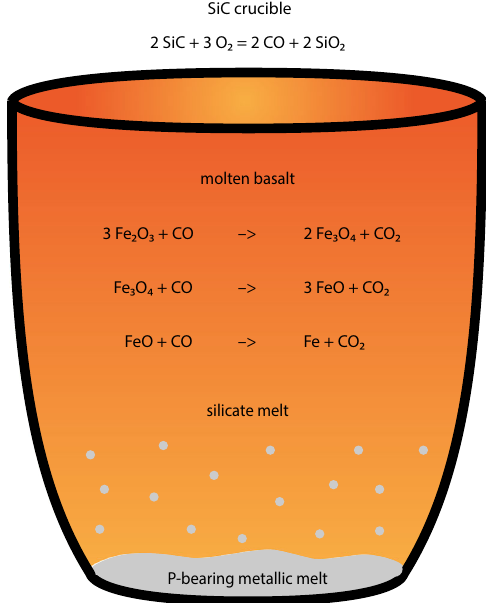
Fig. 7 Metallic melt segregation. Schematic illustration of the spontaneous segregation of metallic melt from silicate melt in the experimental furnace. The silicon carbide crucible degrades into silica and carbon monoxide. The carbon monoxide reduces the basaltic melt. This causes part of the ferric and ferrous iron contained in the basaltic melt to reduce all the way to metallic iron and to precipitate and pool at the bottom of the crucible. Phosphorous, which becomes siderophile under reducing conditions, partially migrates into the metallic melt.